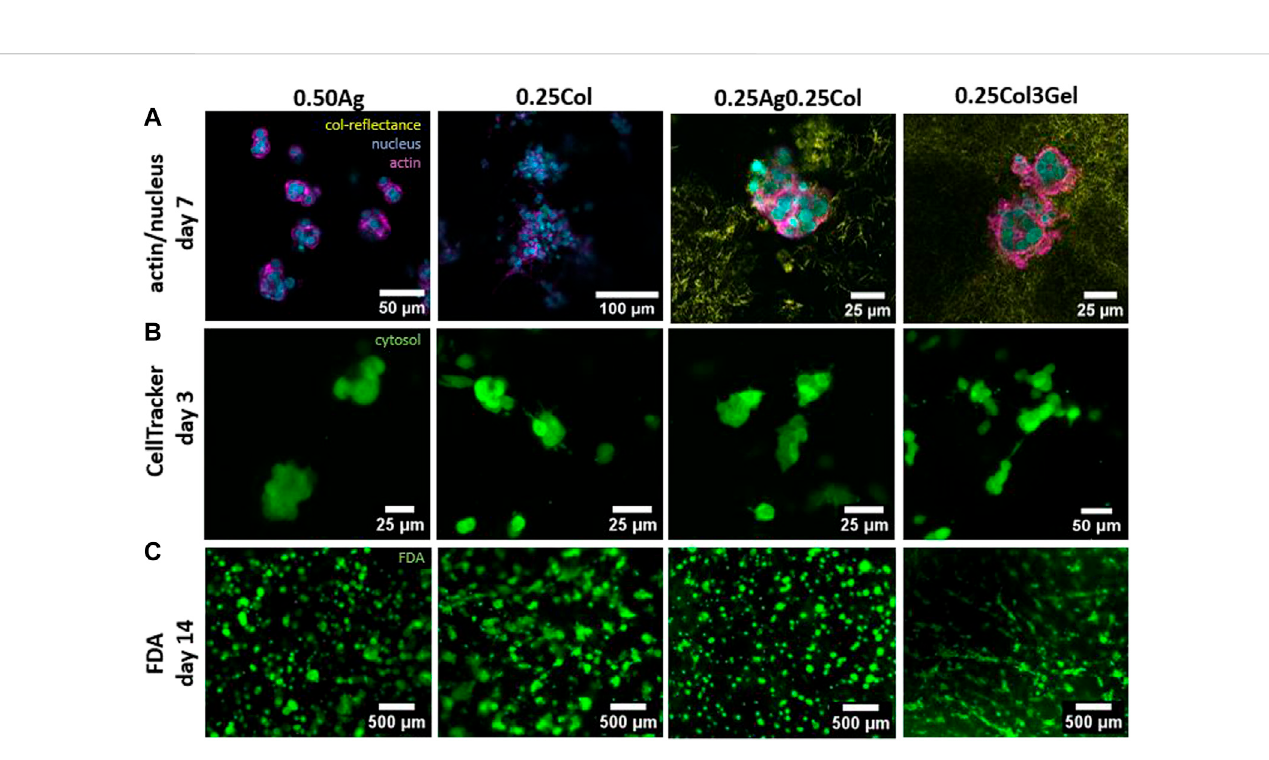
FIGURE 6 Confocal fl uorescence microscopy images of HepG2 cells in 0.50Ag, 0.25Col, 0.25Ag0.25Col, 0.25Col3Gel with actin fi laments (magenta) and cell nuclei (blue) stained on day 7and collagen fi bers visualized byconfocalre fl ectance(yellow) (A) . Imagesof HepG2 cells marked green with CellTracker on day 3 (B) and live cells stained green with FDA on day 14 (C)